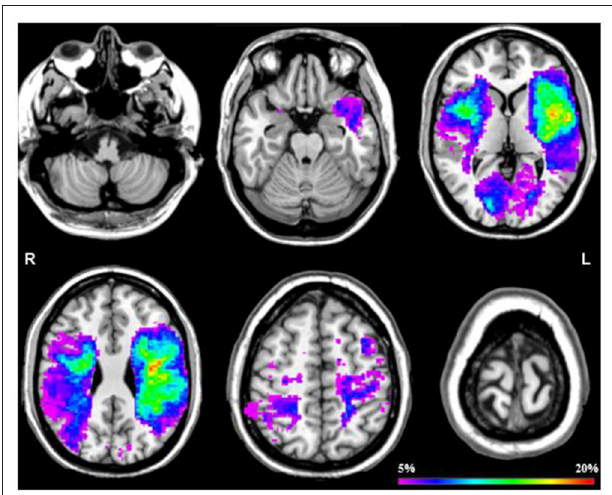
FIGURE 2 | Probability map of all stroke lesions. This probability map displays a overlap across all stroke patients by 6 slices at z = 25, z = 50, z = 75, z = 100, z = 125 en z = 150. The color scale saturates at 20% which means that in 20% of the patients that specific area was